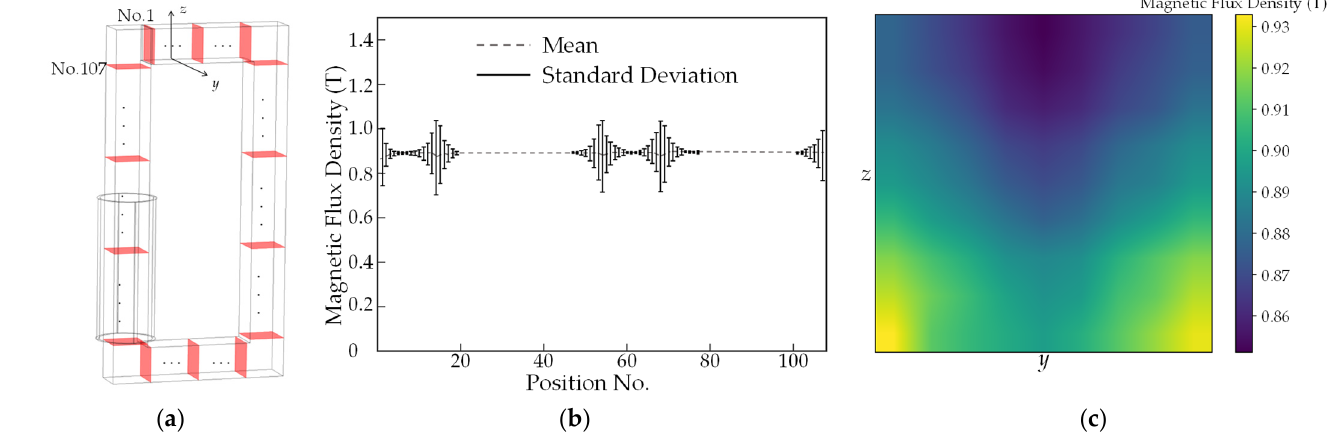
Figure 7. ( a ) The 107 selected equidistant slices of the core; ( b ) The FEM-simulated area-averaged magnetic flux density of core cross-sections over the cycle with the surface standard deviation; ( c ) The magnetic flux density distribution on slice No. 2 as a transient stage near the corner.